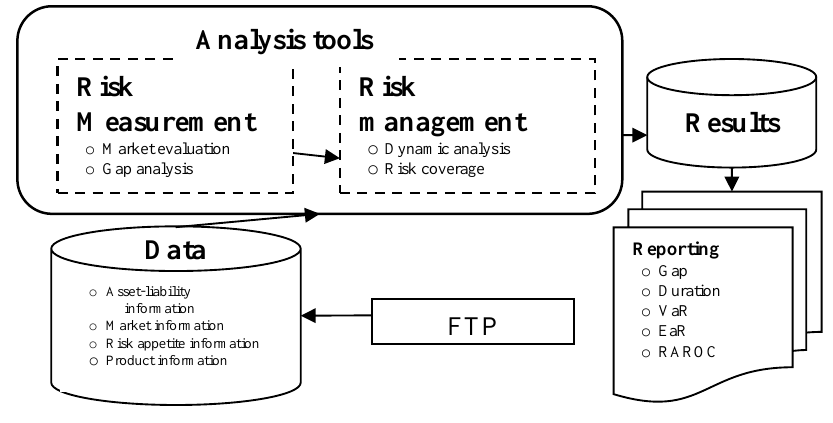
Figure2. Core components of an information system for ALM ( Source: Xenius and Ziemba, 2006:18